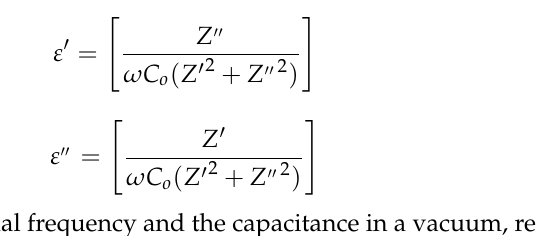
Figure 4. FESEM for ( a ) PSP_1 and ( b ) PSP_2 electrolyte systems at RT.